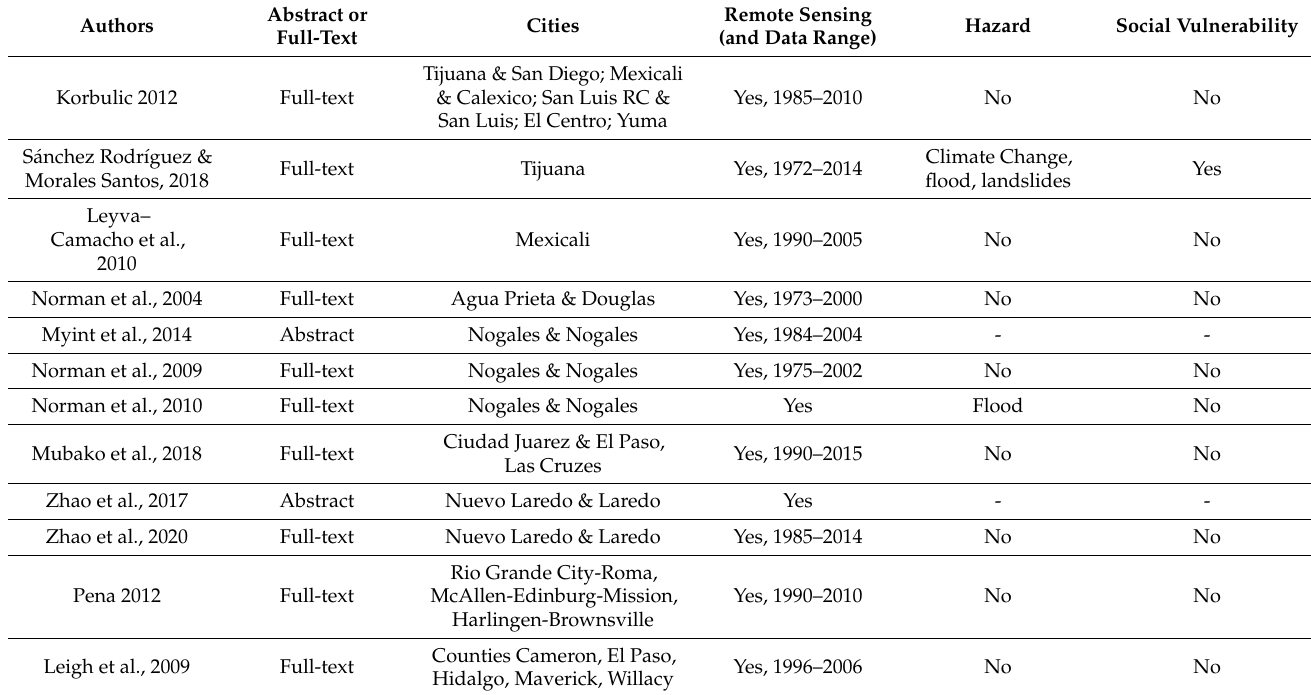
Table 1. Literature for individual cities of the Mexican-US border covering urban growth with mapping, and other